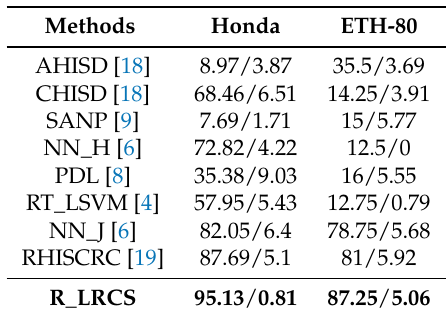
Table 6. Recognition rates and standard deviations of various methods on partially occluded Honda and image-specific corrupted ETH-80 datasets.